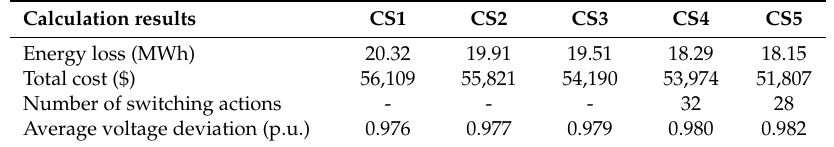
Figure 9. Average nodal voltage deviations for different CSs over a day horizon.